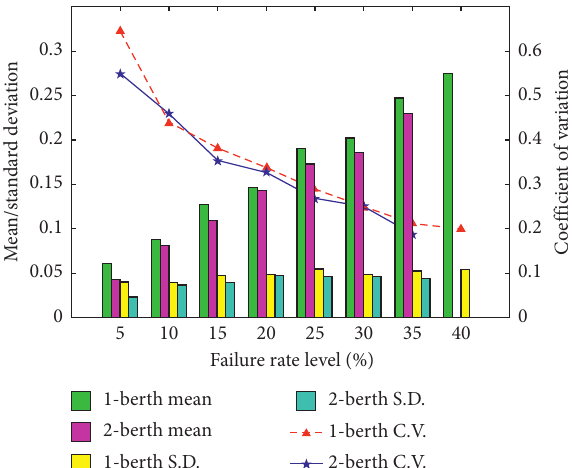
Figure 6: Average mean, S.D., and C.V. of FDR for two types of bus